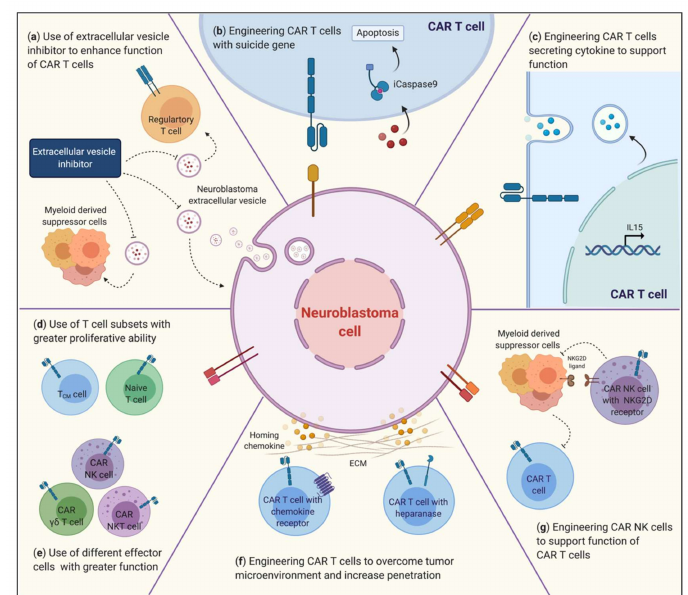
Figure 3. Proposed strategies to improve CARs’ e ffi cacy against neuroblastoma. To enhance the antitumor toxicity of chimeric antigen receptor (CAR) T cells, several strategies can be applied: ( a ) The use of extracellular vesicle (EV) inhibitors. EVs are cargo ships containing functional molecules that enhance tumor growth and metastasis and may decoy CAR immunotherapy. Inhibiting the secretion of EVs from tumor cells may improve the killing e ffi ciency CAR T treatment. ( b ) Engineering CAR T cells with a suicide gene. To improve CARs, and any side e ff ects of CARs, fusing the iCaspase-9 gene in CARs’ structure can break T cell activation via induction of apoptosis in CAR T cells; ( c )